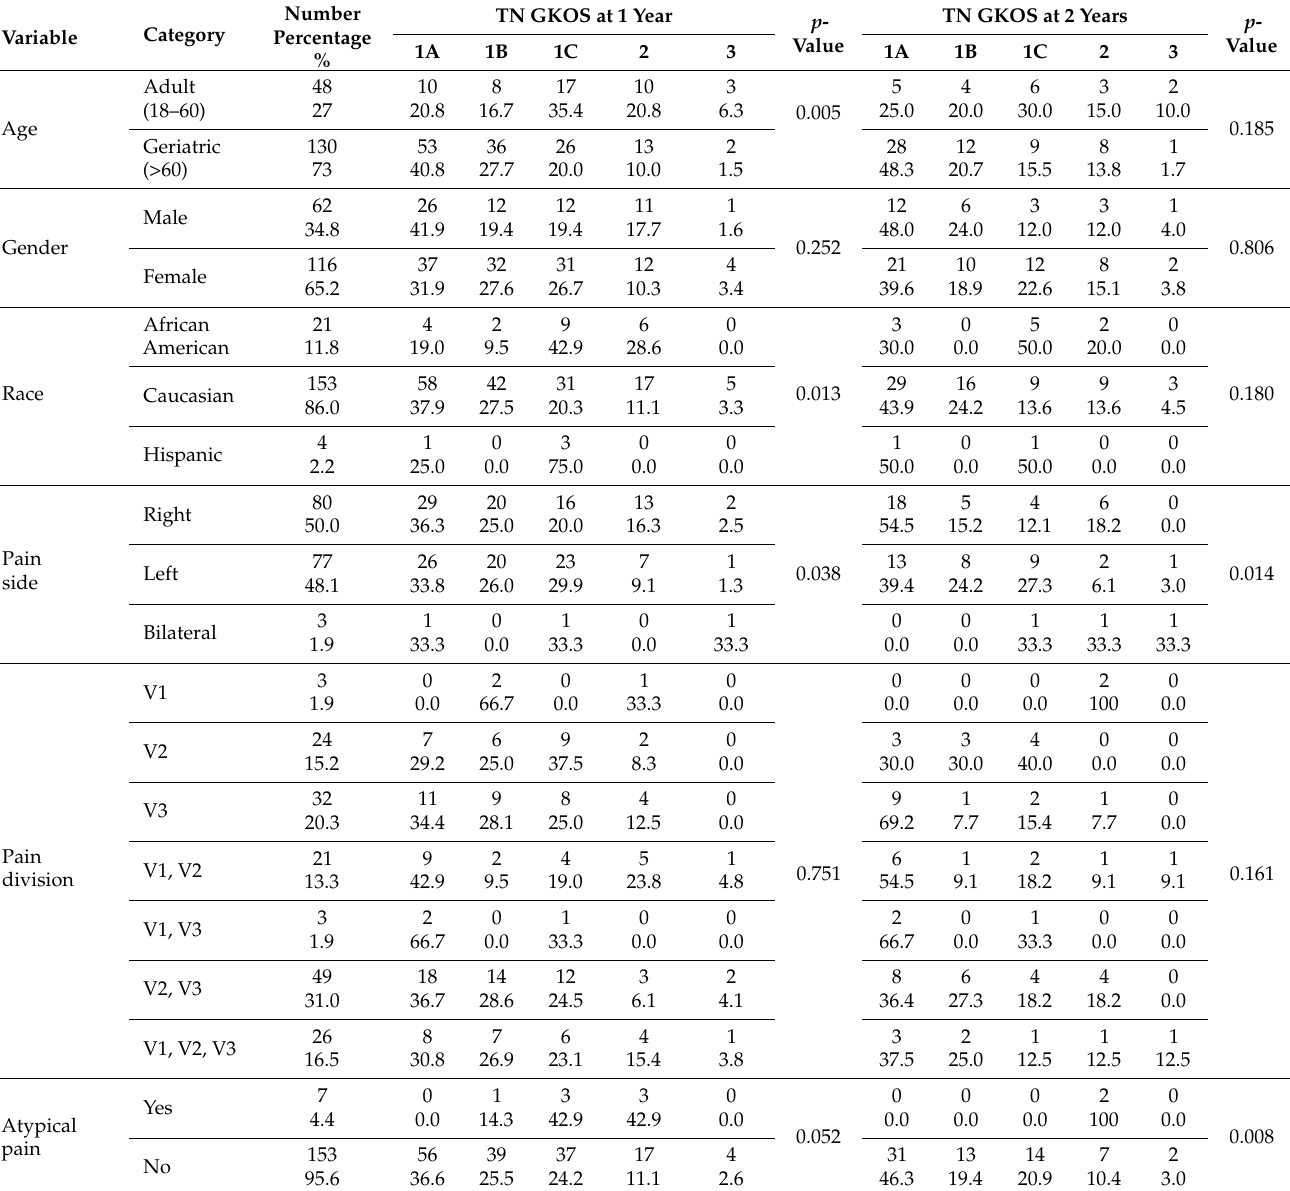
Table 2. Trigeminal neuralgia patient demographics and